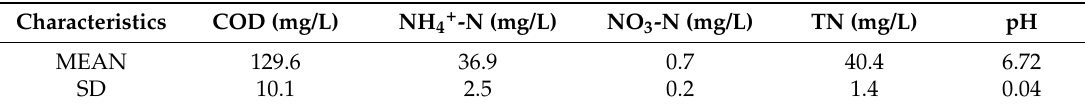
Table 1. The initial concentration of the chemical oxygen demand (COD), ammonia (NH 4+ -N), nitrate nitrogen (NO 3 − –N), total nitrogen (TN), pH, and temperature (T) in wastewater. Characteristics